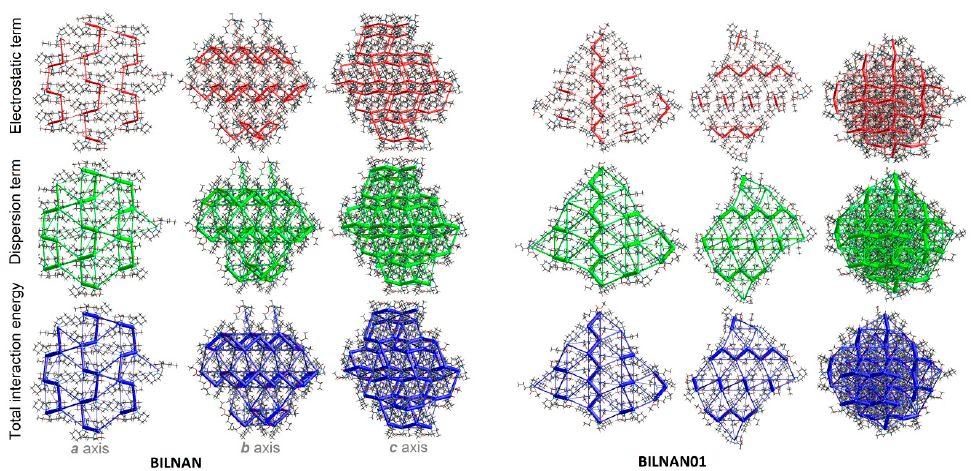
Figure 21. Energy frameworks of diketopiperazine perindopril structures corresponding to the electrostatic and dispersion energy components, and total energy framework along the a, b and c -axis (the tube size: 300).